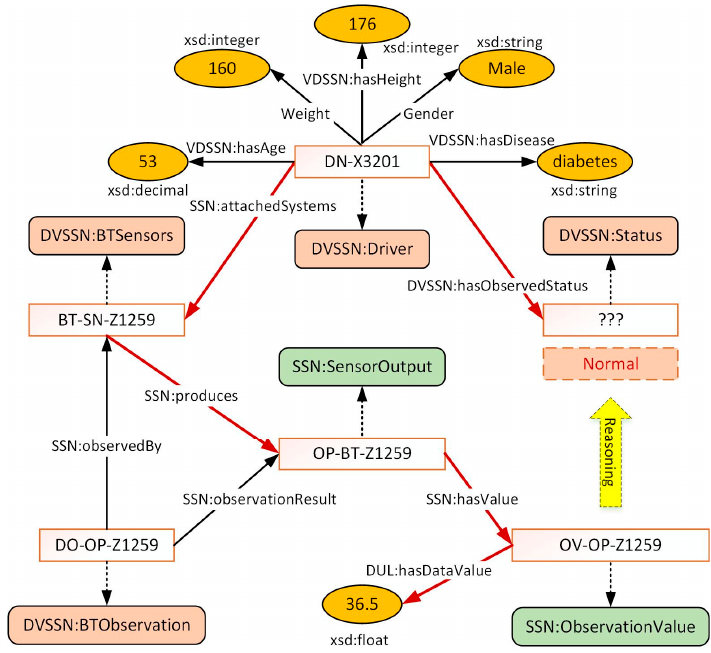
Figure 3. Demonstration of the relationship between instances.